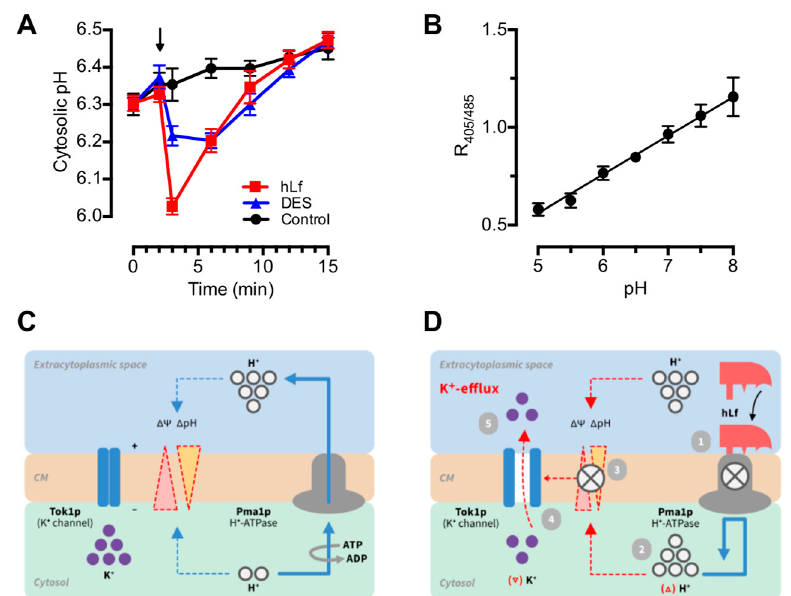
Figure 4. E ff ect of lactoferrin on cytosolic pH. ( A ) Transient cytosolic acidification induced by lactoferrin. Cytosolic pH of C. albicans -adapted pHluorin cells (black line, control), exposed to 5 µ M lactoferrin (red line) or 25 µ M diethylstilbestrol (DES, blue line), was determined at di ff erent times. These inhibitors of fungal Pma1p H + -ATPase were added to the cell suspensions at the indicated time (arrow). Cytosolic pH values were derived from fluorescence intensity measurements at di ff erent times over 15 min and calculated according to the calibration curve. ( B ) Calibration curve showing measured ratio of fluorescence intensity at 405 nm to intensity at 485 nm versus pH of pHluorin-expressing permeabilized cells equilibrated in bu ff ers of increasing pH. Data are shown as means ± SD from duplicates of at least three independent experiments. ( C ) The normal activity of Pma1p H + -ATPase of cytoplasmic membrane (CM) generates a proton gradient ( ∆ pH) and an electrical ( ∆Ψ ) gradient (negative inside) indicated by dashed lines. Cytosolic K + is retained by the negative electrical charge. ( D ) The figure shows the sequence of linked events induced by lactoferrin (i.e., cytosolic acidification and K + -e ffl ux). The blocking e ff ect of lactoferrin on Pma1p H + -ATPase (1) causes a transient accumulation of protons in cytosol, detected as cytosolic acidic pH shift (2), and the subsequent loss of electrochemical gradient (3). As a consequence, the voltage-dependent channel Tok1p opens upon plasma membrane depolarization (4) allowing K + -e ffl ux